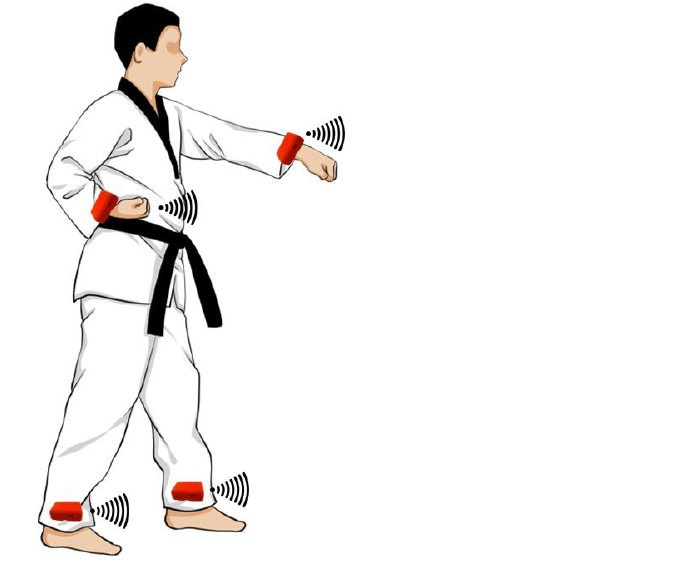
Figure 7. Positioning of motion sensors in the taekwondo athlete.